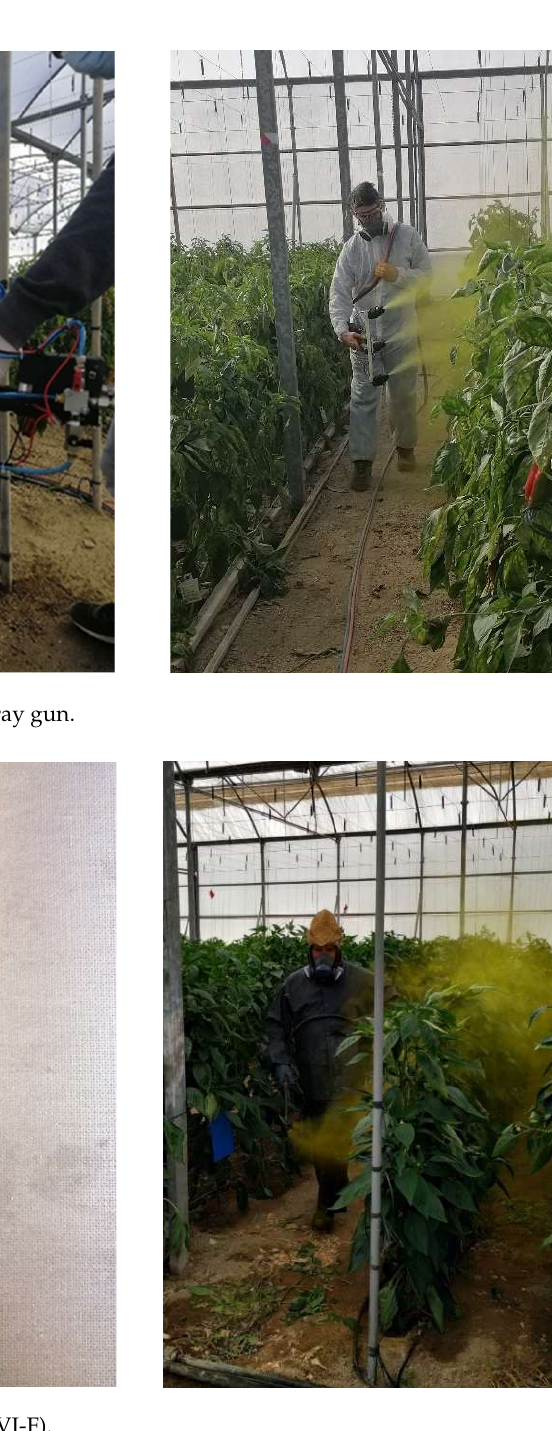
Figure 2. Hand-held spray gun (NOVI-F).